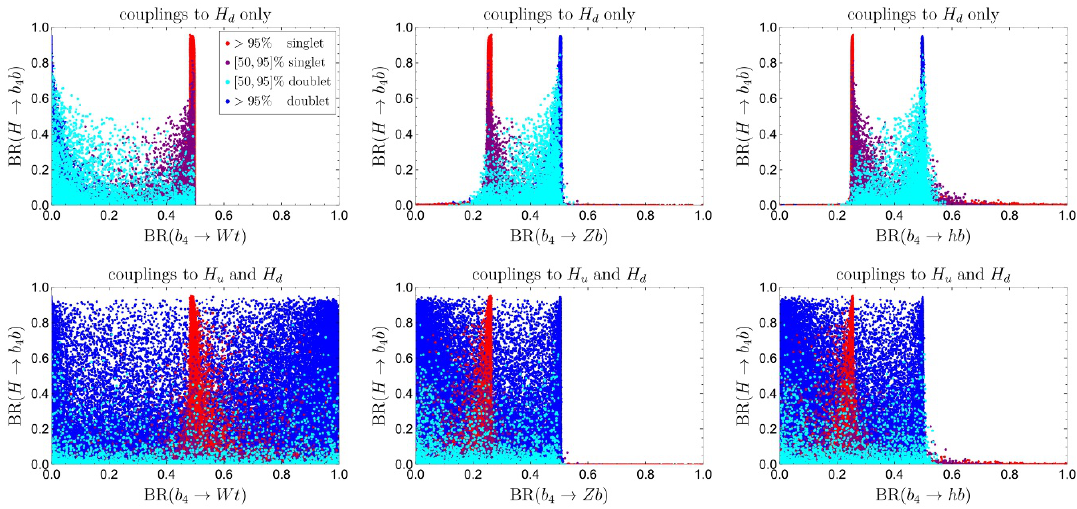
Figure 6 . Correlations between the branching ratio of H ! b 4 b and branching ratios of b 4 assuming couplings to H d only (top) and couplings to H u and H d (bottom). Di(cid:11)erent colors correspond to di(cid:11)erent singlet/doublet fractions of b 4